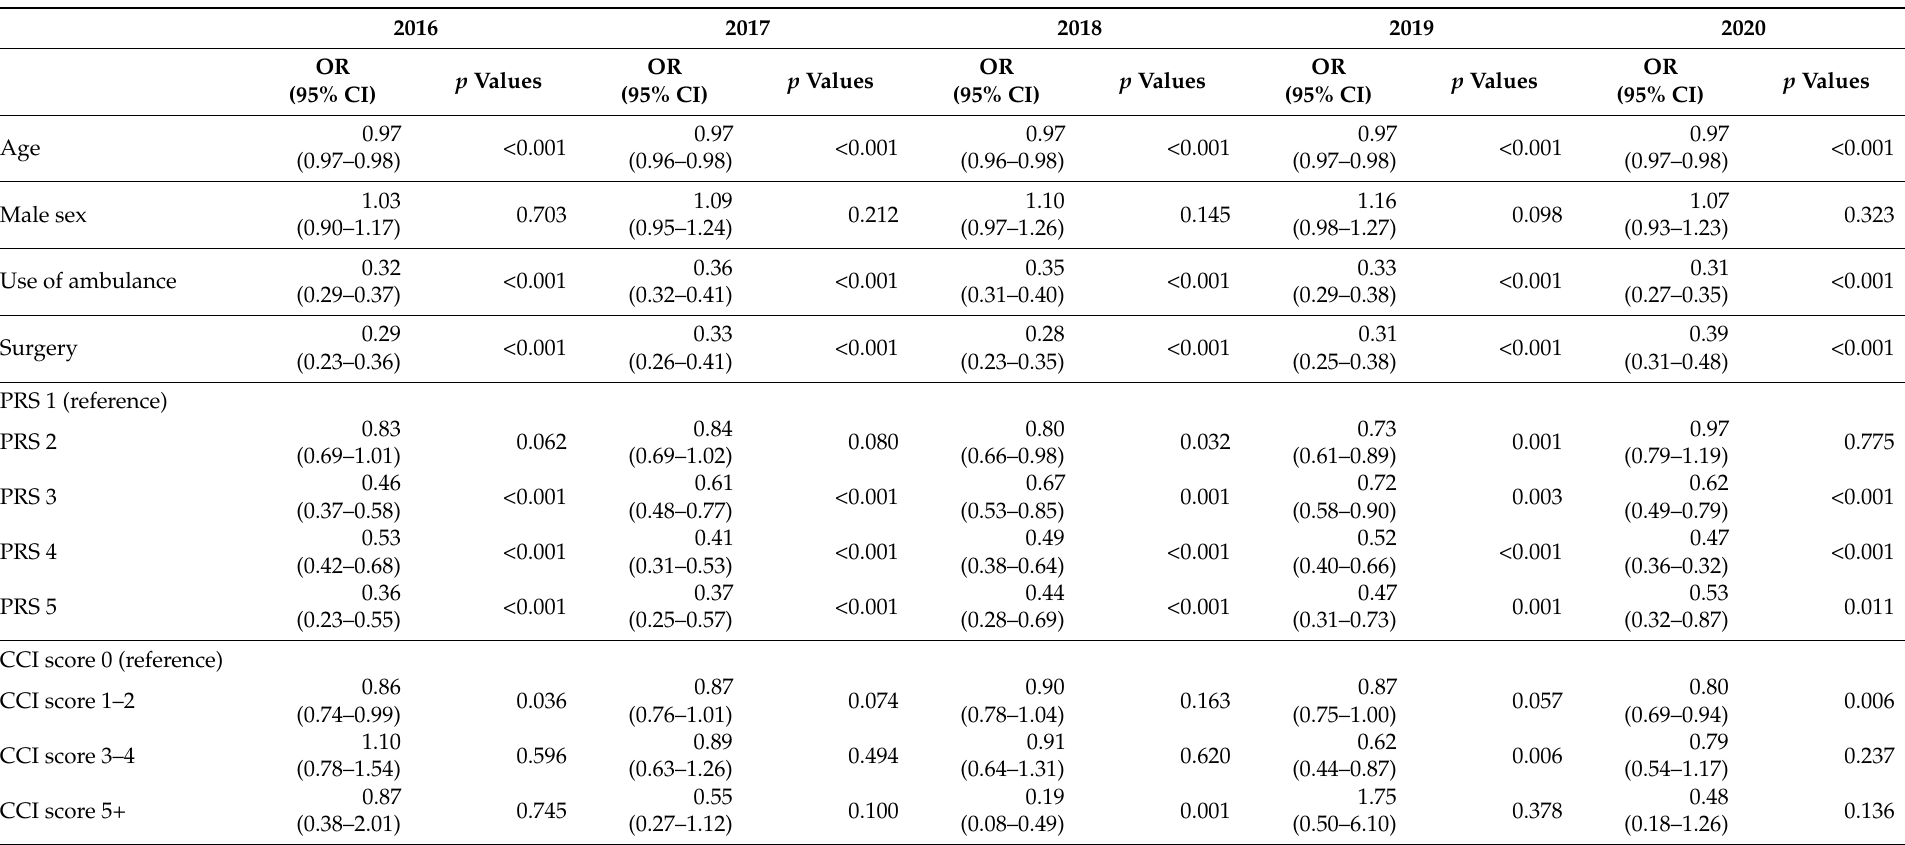
Table 4. Variables in the logistic regression analysis in single-year HSHR